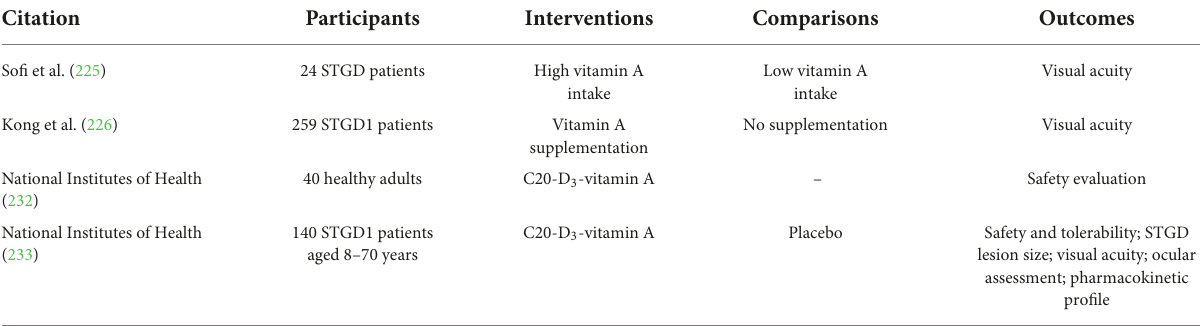
TABLE 3 Human-based experimental studies relating to vitamin A treatment for STGD, with PICO characteristics summarised. Citation